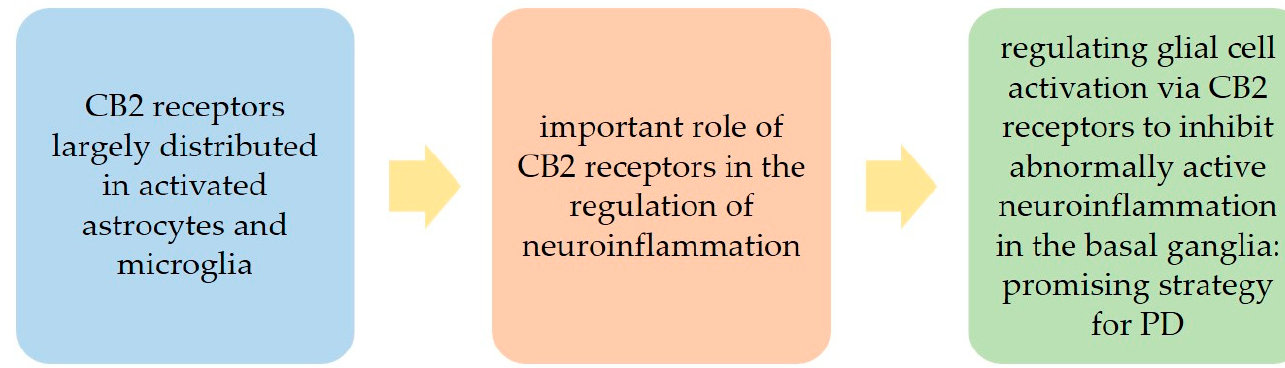
Figure 1. Potential value of the role of the cannabinoid type 2 (CB2) receptors in the regulation of neuroinflammation in Parkinson’s disease (PD).